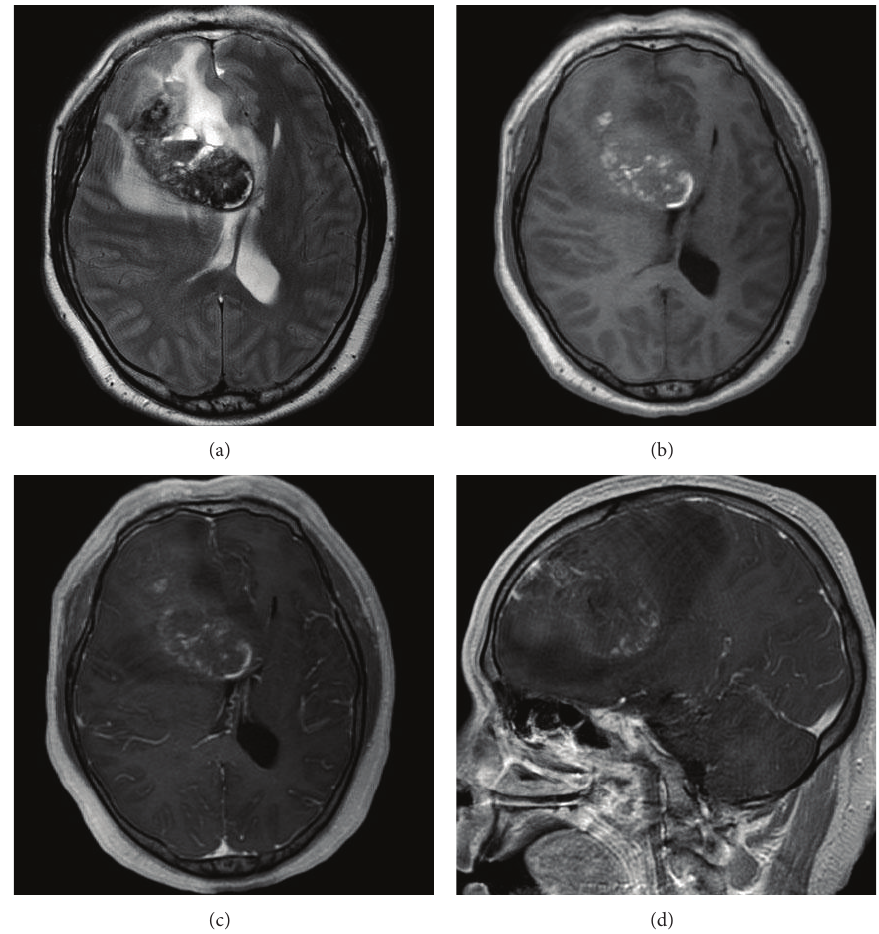
Figure 1: Axial T2-weighted imaging (WI) (a), axial T1-WI (b), axial T1-WI with gadolinium (c), and sagittal T1-WI with gadolinium (d) magnetic resonance images showing a huge tumor with intratumoral hemorrhage in the right frontal lobe that led to subfalcial and transtentorial